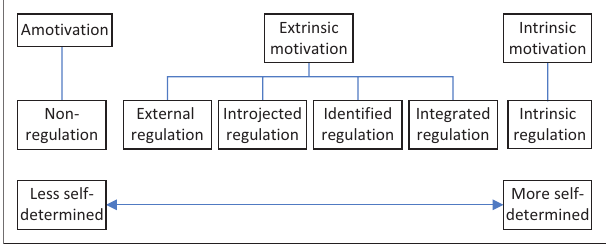
FIGURE 1: The self-determination